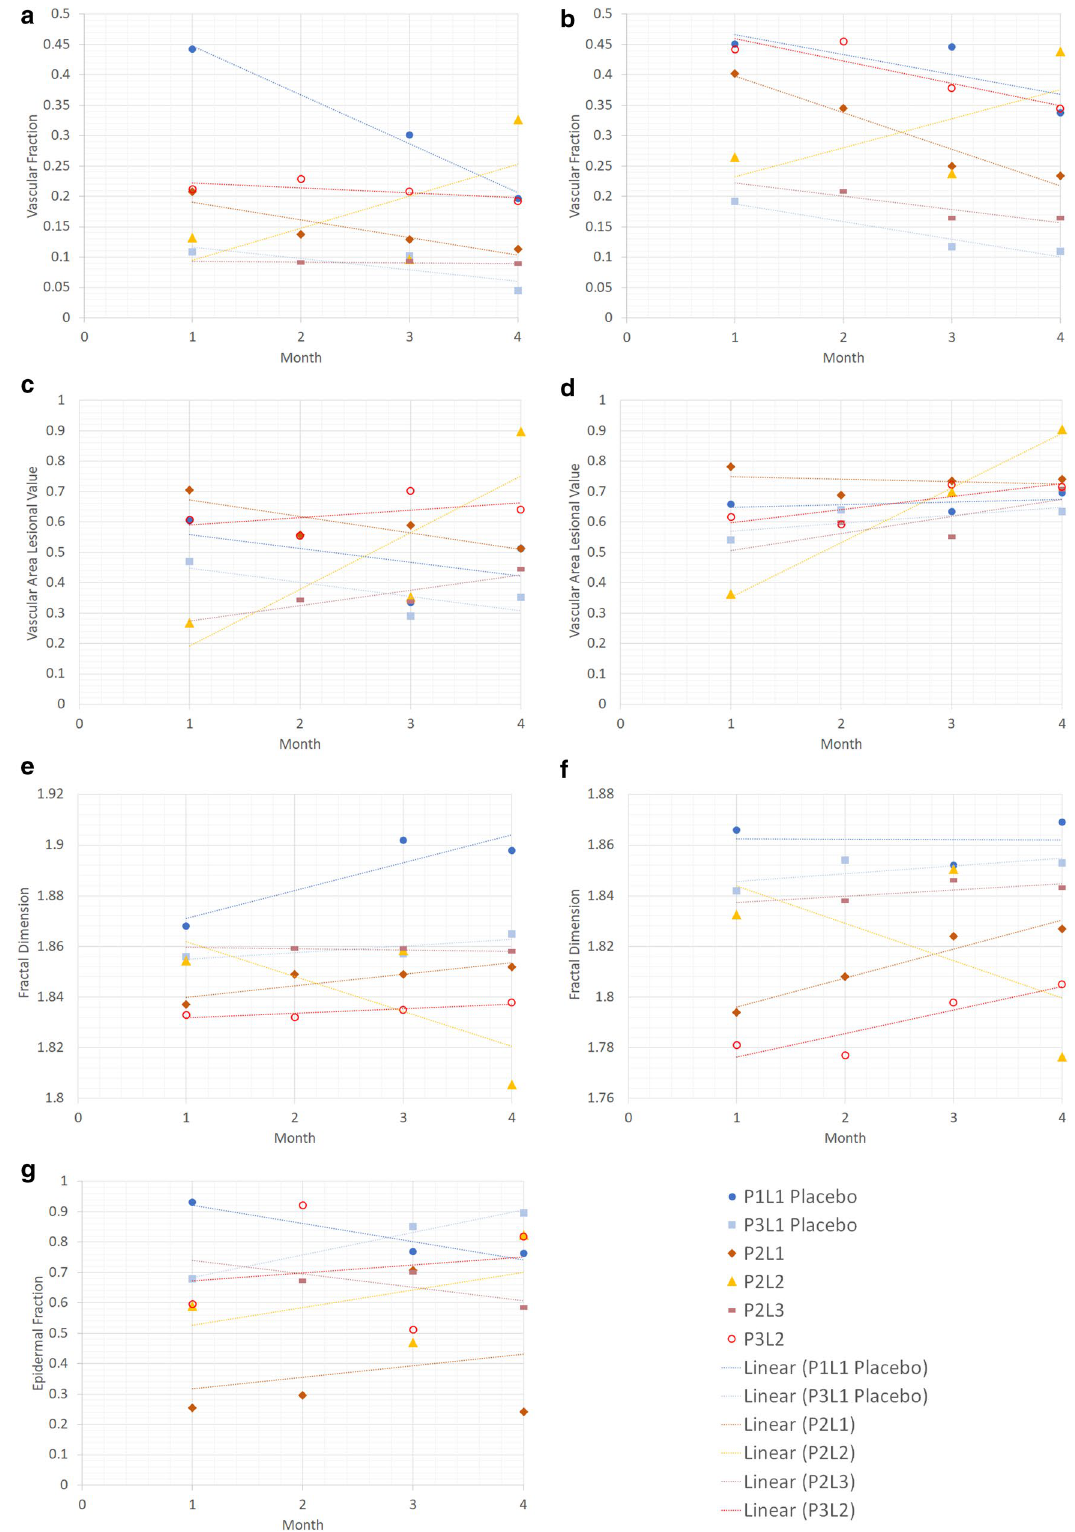
Figure 5. Graph of results for ( a , b ) vascular fraction, ( c , d ) VALVe, ( e , f ) Fractal Dimension, and ( g ) epidermal fraction, with ( a , c , e ) being superficial and ( b , d , f ) being deep, with ( h ) as a legend for all